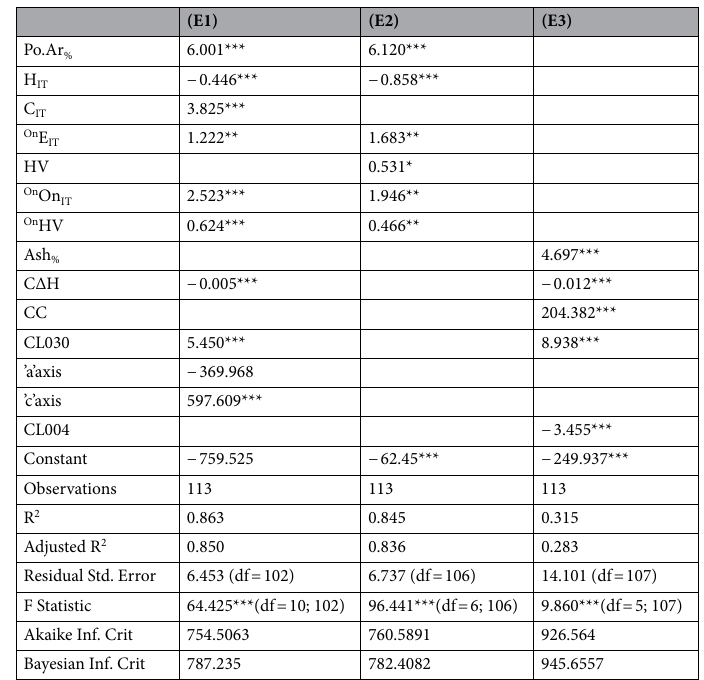
Table 1. Regression coefficient and diagnostic results. Stepwise regression based on the full set of parameters (E1), only nanoindentation (E2) and physicochemical modifications (E3) (* p < 0.01; ** p < 0.05; *** p <